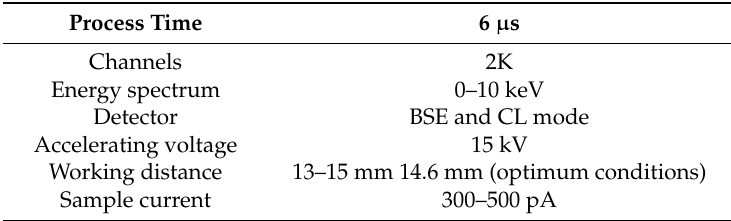
Table 1. SEM operating